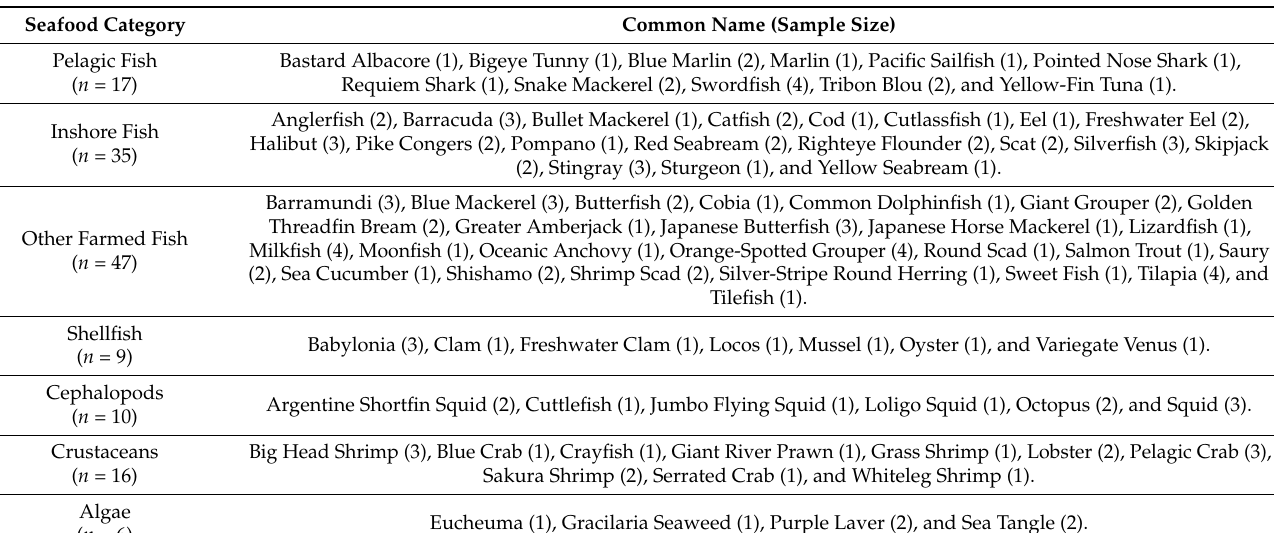
Table 1. Classification of the analyzed seafood